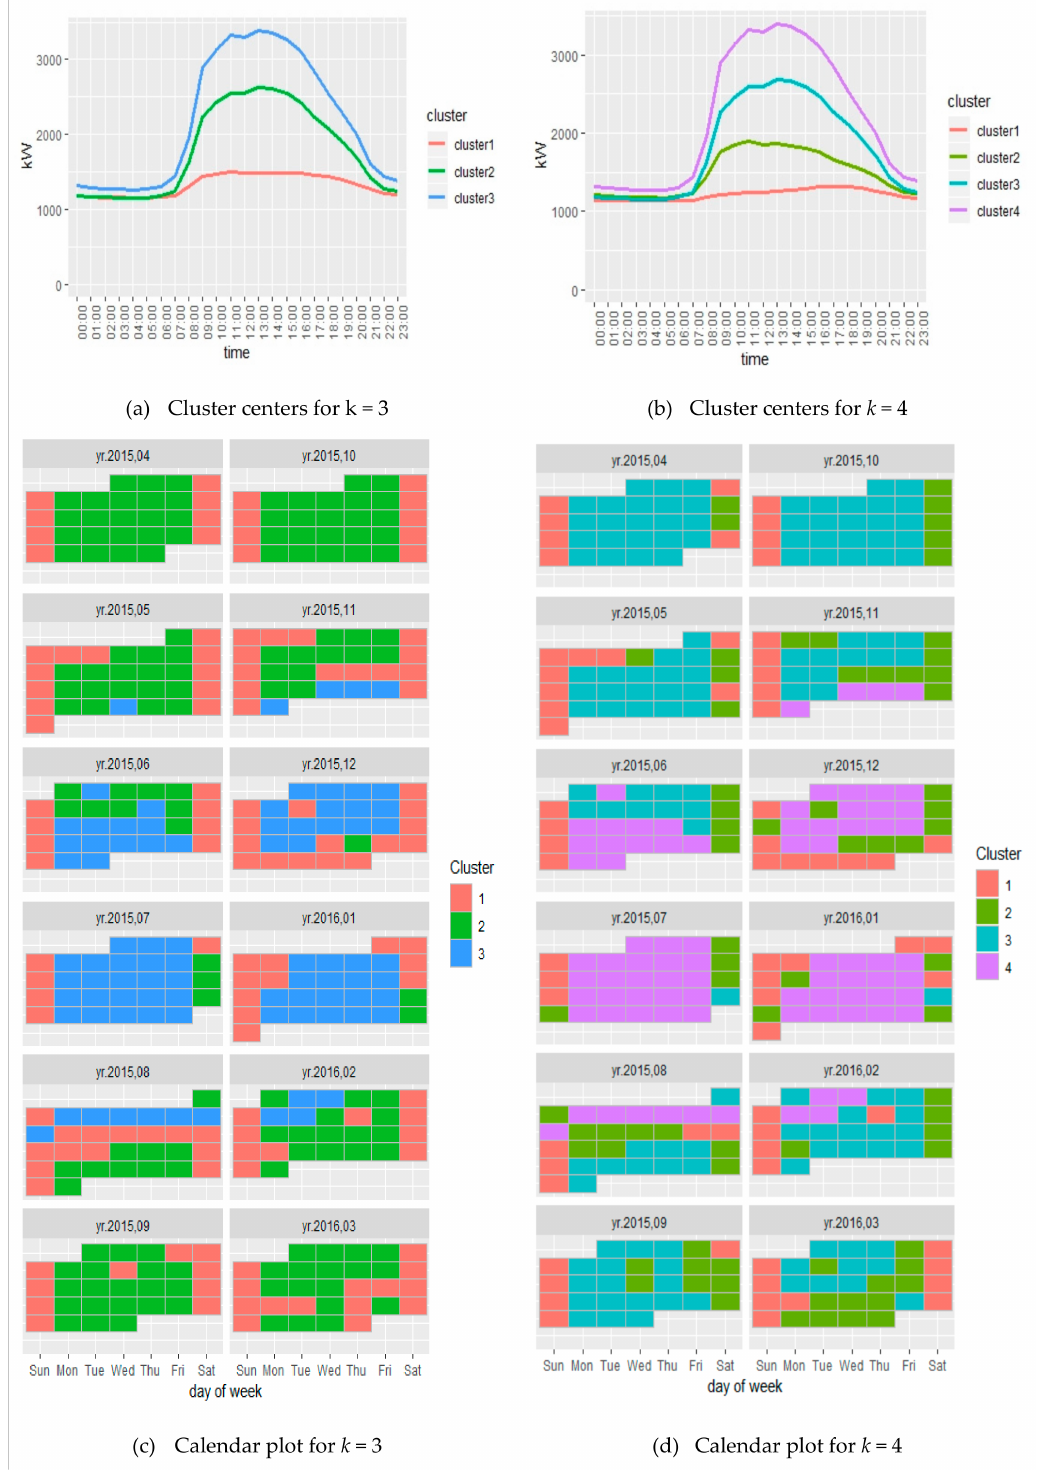
Figure 9. Clustering result of Chubu university. The cluster centers for ( a ) k = 3 and ( b ) k = 4. The calendar plot for ( c ) k = 3 and ( d ) k =